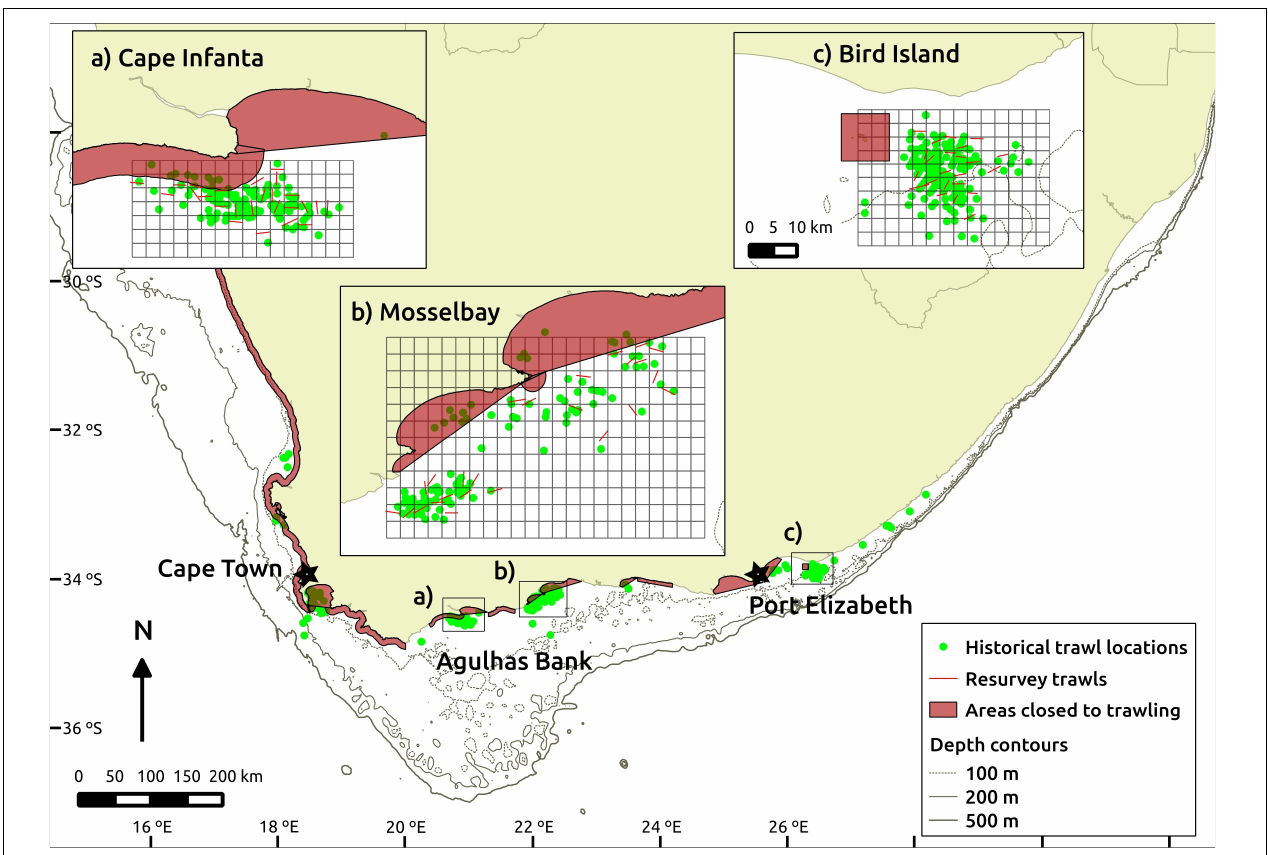
FIGURE 1 | Map showing the location of historical trawl samples, together with the sampling grids and re-survey trawl locations at the three chosen re-survey sites (a–c) . Scale used across the three inserts is consistent. Areas closed to trawling include designated trawl closures and legislated marine protected areas at the time of the fieldwork. Historical trawls represented by start position of trawl, whereas re-survey trawls are shown as a straight line connecting start- and